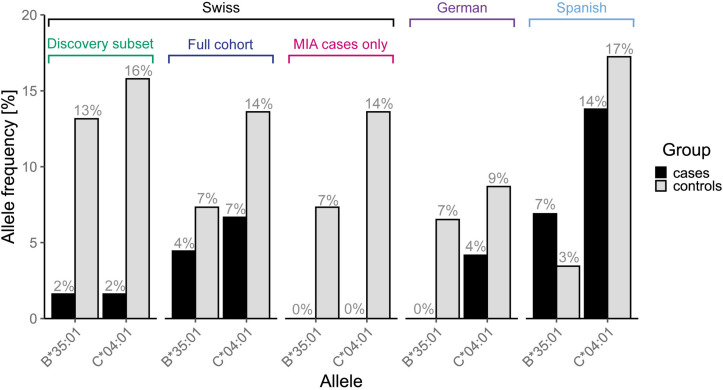
Allele frequencies of the two linked candidate alleles, HLA-B∗35:01 and –C∗04:01, that showed a stronger association in the full cohort when restricting the analysis to agranulocytosis cases only, in all analyzed cohorts and subsets thereof.